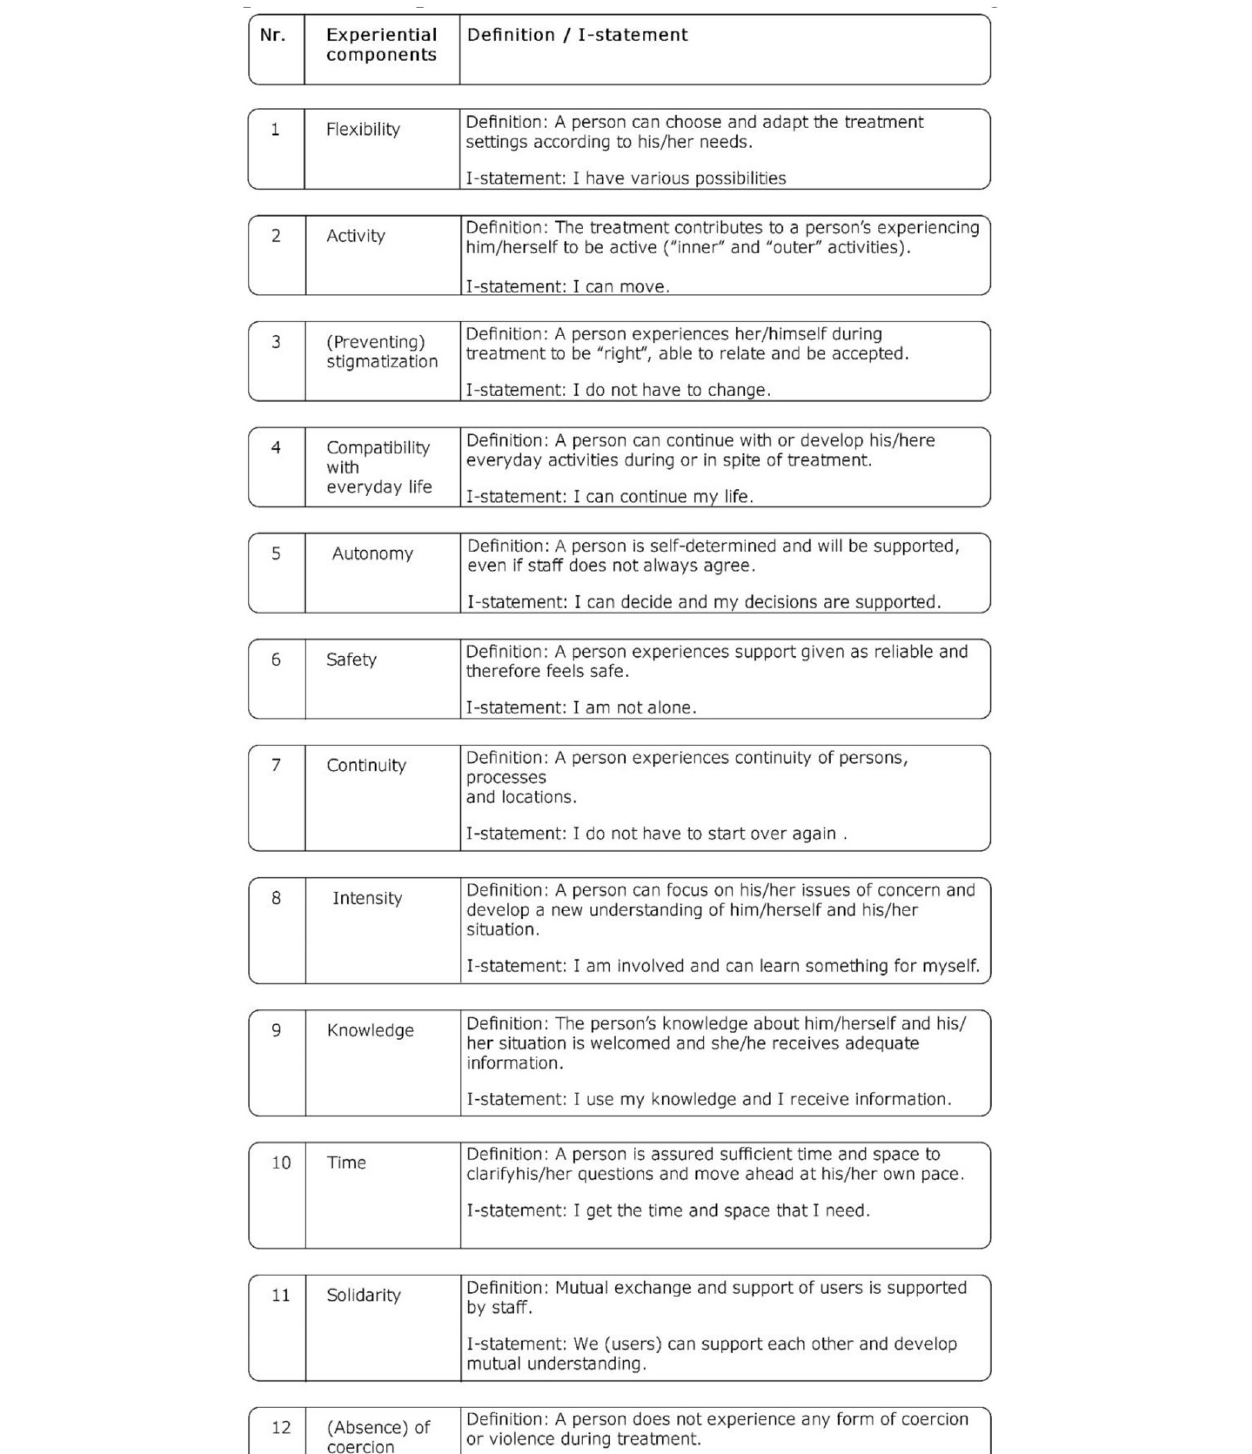
Frontiers in Psychiatry |